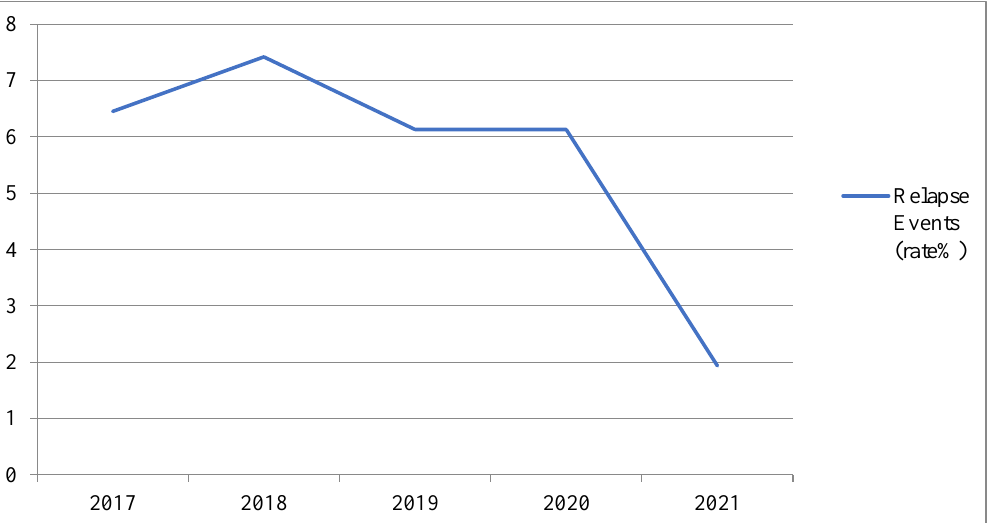
Figure 2. Trend of Relapses (%) during years 2017 – 2021 (periods considered: March – September). Lastly, the results of the multivariable analysis that assessed factors associated with the occurrence of AEFIs revealed a statistical significance for age, sex, and therapy with ocrelizumab ( p < 0.05) (Table 3), suggesting that AEFIs were less common in young pa- tients (negative β coefficient = -0.02, p = 0.03), while they were more common in female patients (positive β coeffi cient = 0.361, p = 0.03) and in patients who were receiving ocrel- izumab (positive β coefficient = 0.477, p = 0.022). Table 3. Multivariable analysis assessing factors associated with Adverse Events Following Immun- ization (AEFIs). Variable